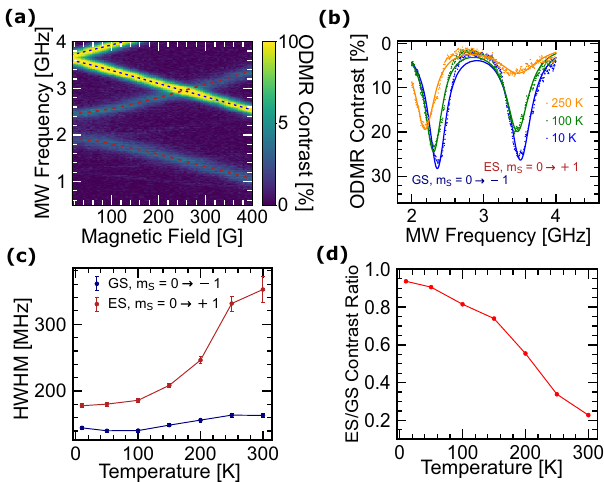
Fig. 4 Temperature dependence of the ES ESR. a Magnetic- fi eld- dependent CW ODMR at T = 10 K and P MW ≈ 50 mW. ESR fi ts to Eq. (2) have been marked with blue and red dashed lines, respectively. b CW ODMR spectra at T = 250K (orange), 100 K (green), and 10 K (blue) at B = 450 G and P ≈ 2.51 W. c Temperature dependence of the ESR 0 MW linewidths for both the GS (blue) and ES (red) at P MW ≈ 2.51 W. Error bars represent the standard deviation of the fi tted parameter. d Relative contrast of the ES ESR with respect to the GS ESR contrast at P MW ≈ 2.51 (cid:1) (cid:3) (cid:1) in the